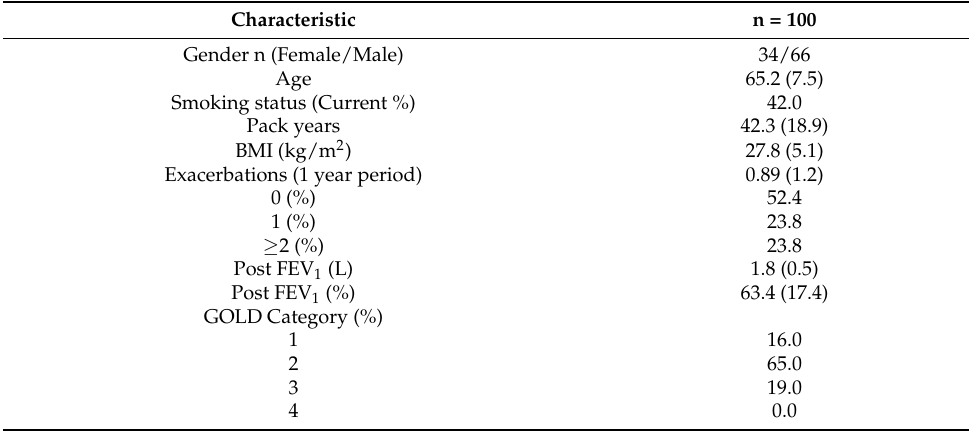
Table 1. Baseline Demographics: Summaries are presented as percentages or Mean (SD) as appropri- ate (n = 100